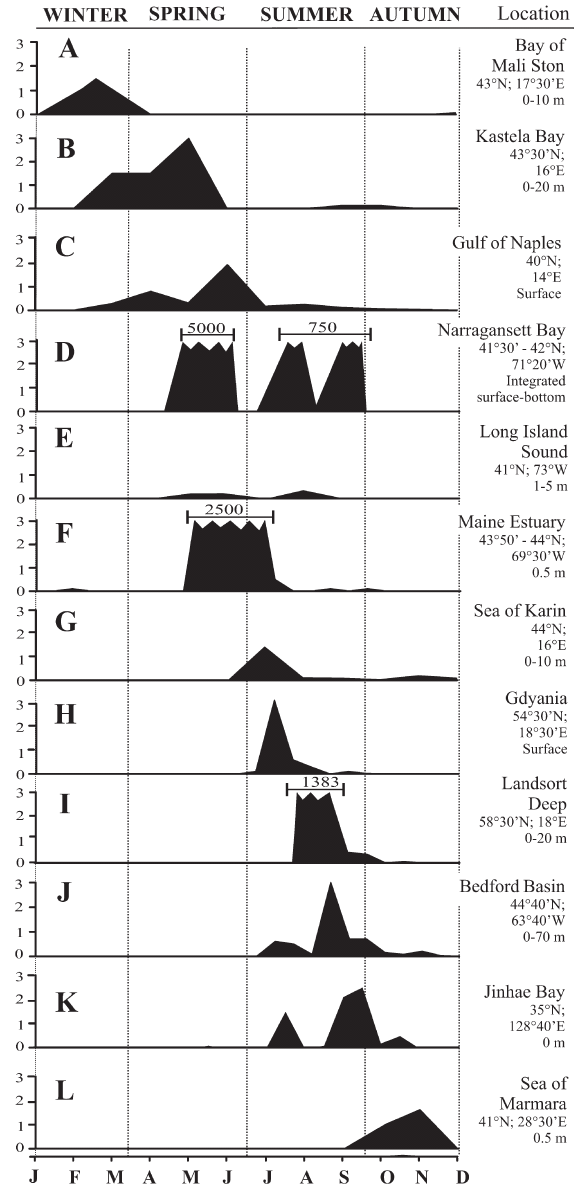
Fig . 8. – temporal density fluctuation of Helicostomella spp. and metacylis annulifera (a-L: 10 2 ind. L -1 , except for J and K: 10 3 ind. L -1 ) in neritic marine environments from previous studies which include detailed information about annual cycles. a, B, G, H, J and K: modified from Kršinic´ (1987a), Bojanic´ (2001), Kršinic´ (1987b), Wasik and Mikolajczyk (1996), Paranjape (1987) and Kim et al. (2007), respectively. c, d, e, F, i and L: graphs built from data sets provided by Modigh and castaldo (2002), Hargraves (1981), capriulo and carpenter (1983), Sanders (1987), Johansson et al. (2004) and Balkis (2004), respectively. d, e, F: only monthly high- est values. d, H, i: no information available for winter. d, F, i: num- bers over the profiles correspond to maximum density (ind. L -1